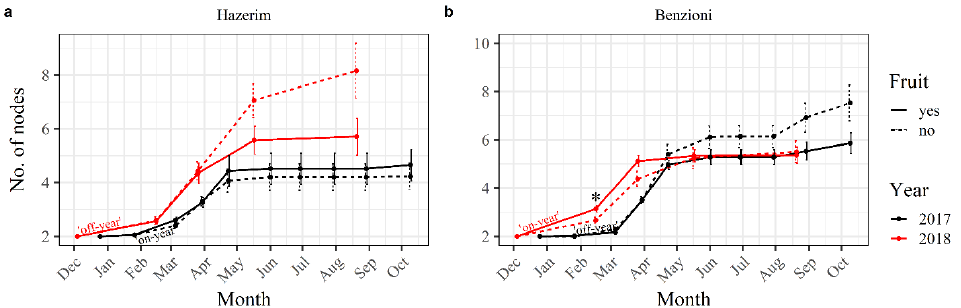
Figure 1. Effect of fruit removal on node number in cvs. Hazerim ( a ) and Benzioni ( b ). Values are mean ± SE of six plants per cultivar. Data are presented for 2017 (black lines) and 2018 (red lines). We measured 12 branches on each plant, six of which had their fruit removed in February (dashed lines), and six that were untreated (solid lines). * Significant difference ( P ≤ 0.05, t -test) between treatments in the same year for the same cultivar.